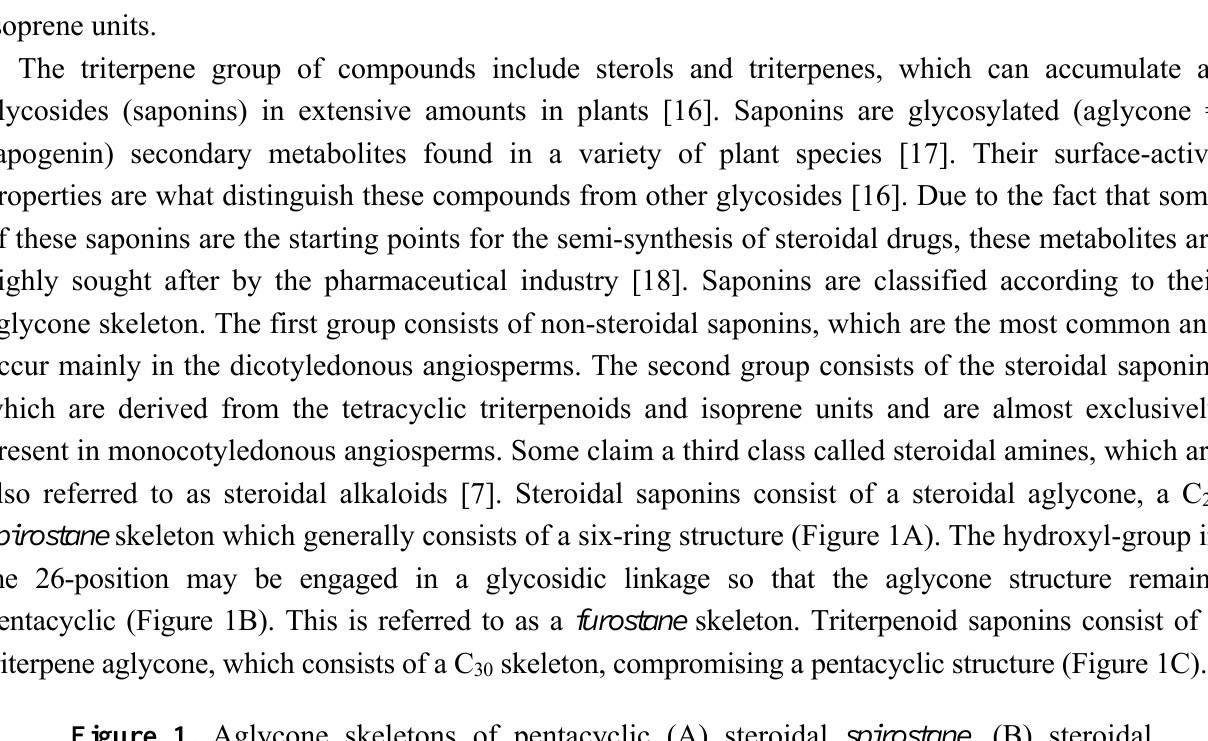
Figure 1. Aglycone skeletons of pentacyclic (A) steroidal spirostane , (B) steroidal furostane and (C) triterpenoid saponins. The R-group is a sugar moity [16]. Tetracyclic terpenes such as lanosterol, sitosterol and cycloartenol can also be derived from oxidosqualene through a different pathway utilizing cycloartenol synthase (CAS